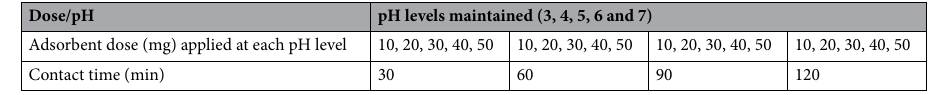
Table 1. Experimental set up for metals adsorption from synthetic wastewater.